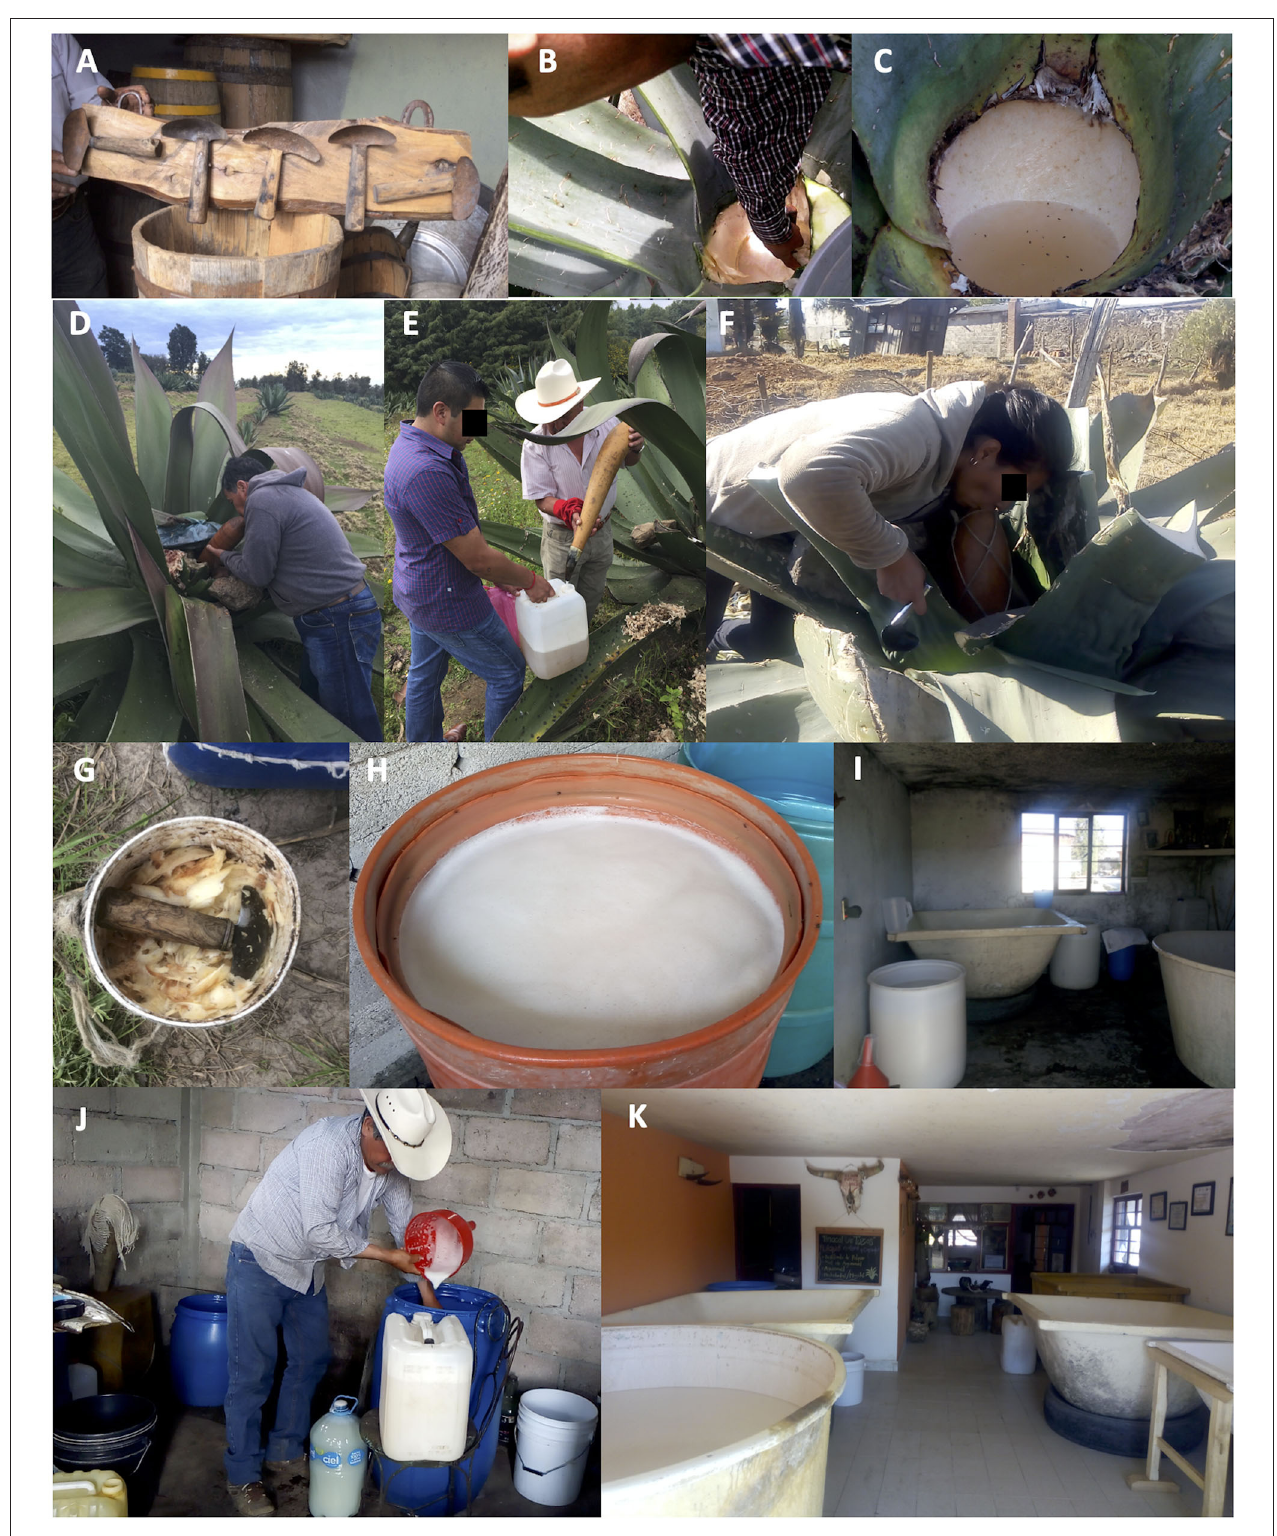
FIGURE 2 | Aguamiel collection and relevant traditional pulque production operations. (A) Metallic scraping tools or raspador. (B) Scraping process of the cajete’s wall. (C) A close view of the cajete with accumulated aguamiel. (D–F) Aguamiel extraction by the tlachiqero using the traditional acocote and the sap’s transference into a plastic container for transport to the tinacal. (G) Residual wall material or metzal in a plastic bucket after the scraping of the cajete. (H–K) Diversity of tinacales, fermentation vessels and vats. Images (A,B,F,G–K) were kindly provided by Mrs. E. Velázquez Gutiérrez.